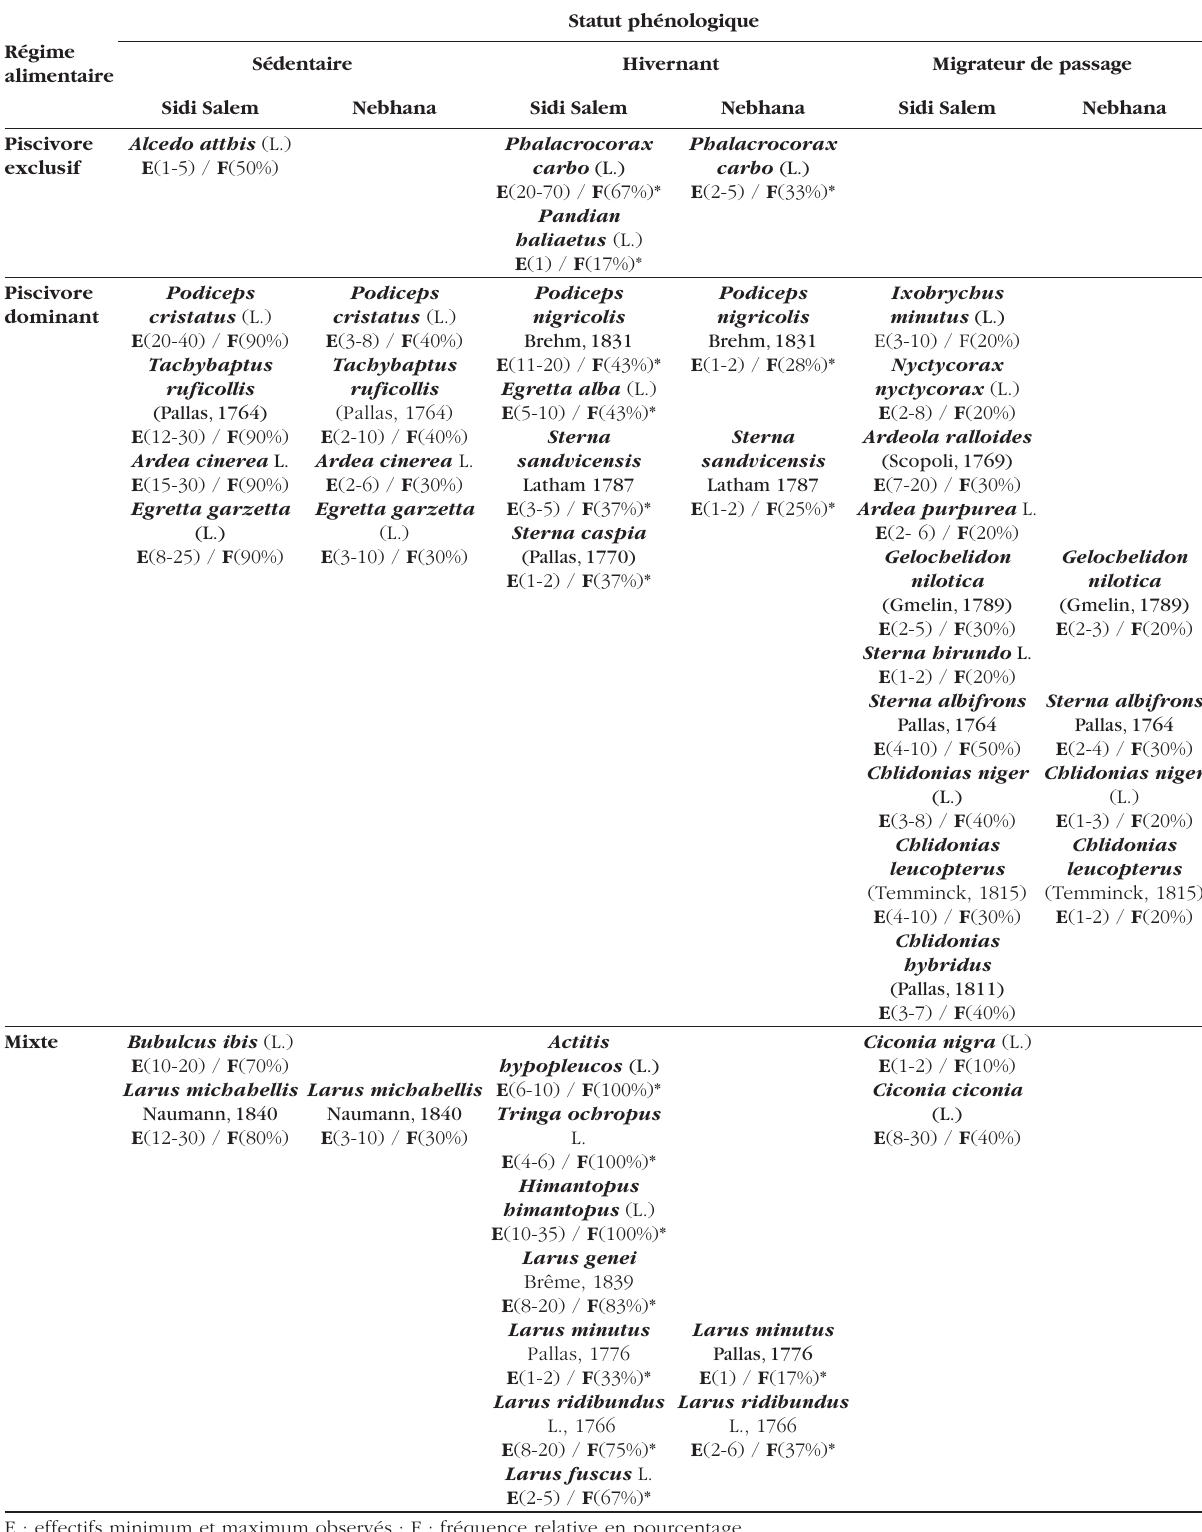
Tableau III. – Composition spécifique de l’avifaune aquatique observée dans les deux retenues de barrages